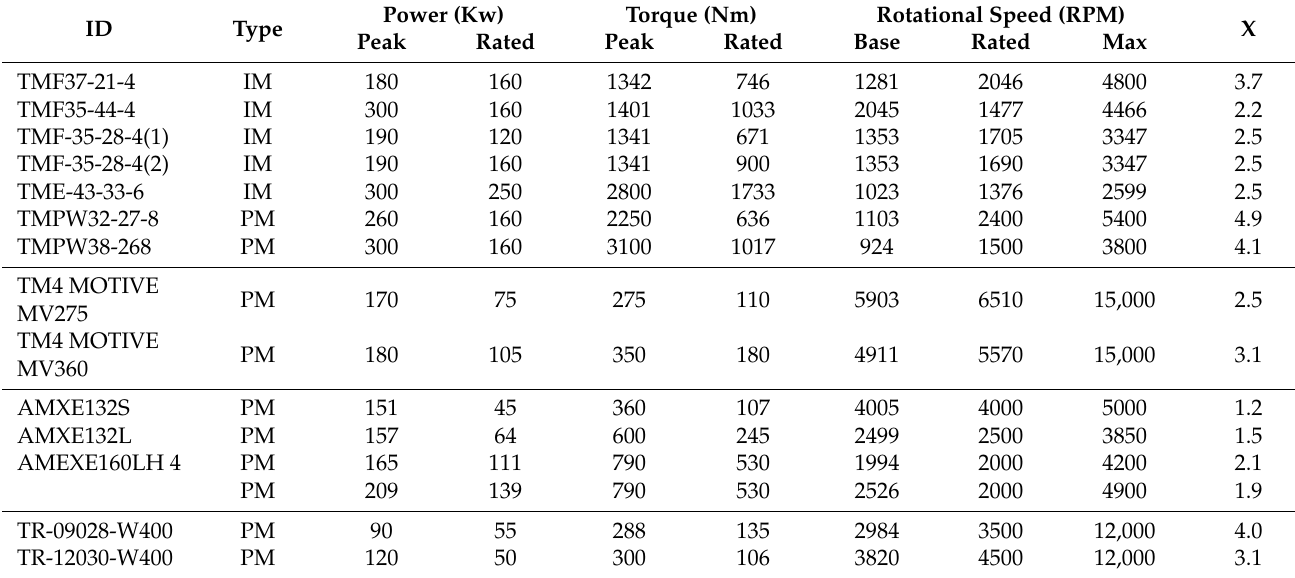
Table 1. Preliminary selection table of electric minibus motors. The table contains the actual values of the electric motors that were used in [16] for a systematic evaluation of motor